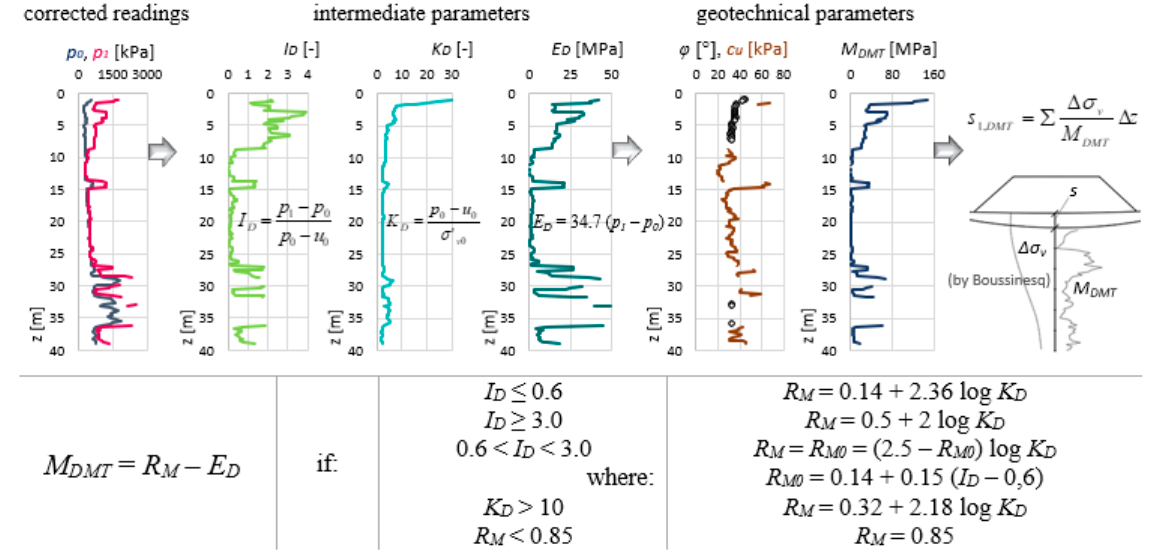
Figure 5. Scheme for settlement prediction by DMT (where: p 0 and p 1 —corrected first and corrected second reading, I D — material index, K D —horizontal stress index, E D —dilatometer modulus, φ —friction angle, u 0 —equilibrium pore pressure, M DMT —constrained modulus, σ v —vertical stress, σ ’ v0 —effective overburden stress, z —depth, R M —correction factor, s —settlements; data comes from the DMT performed on the embankment axis at a distance of 1 km from the TSF dam).